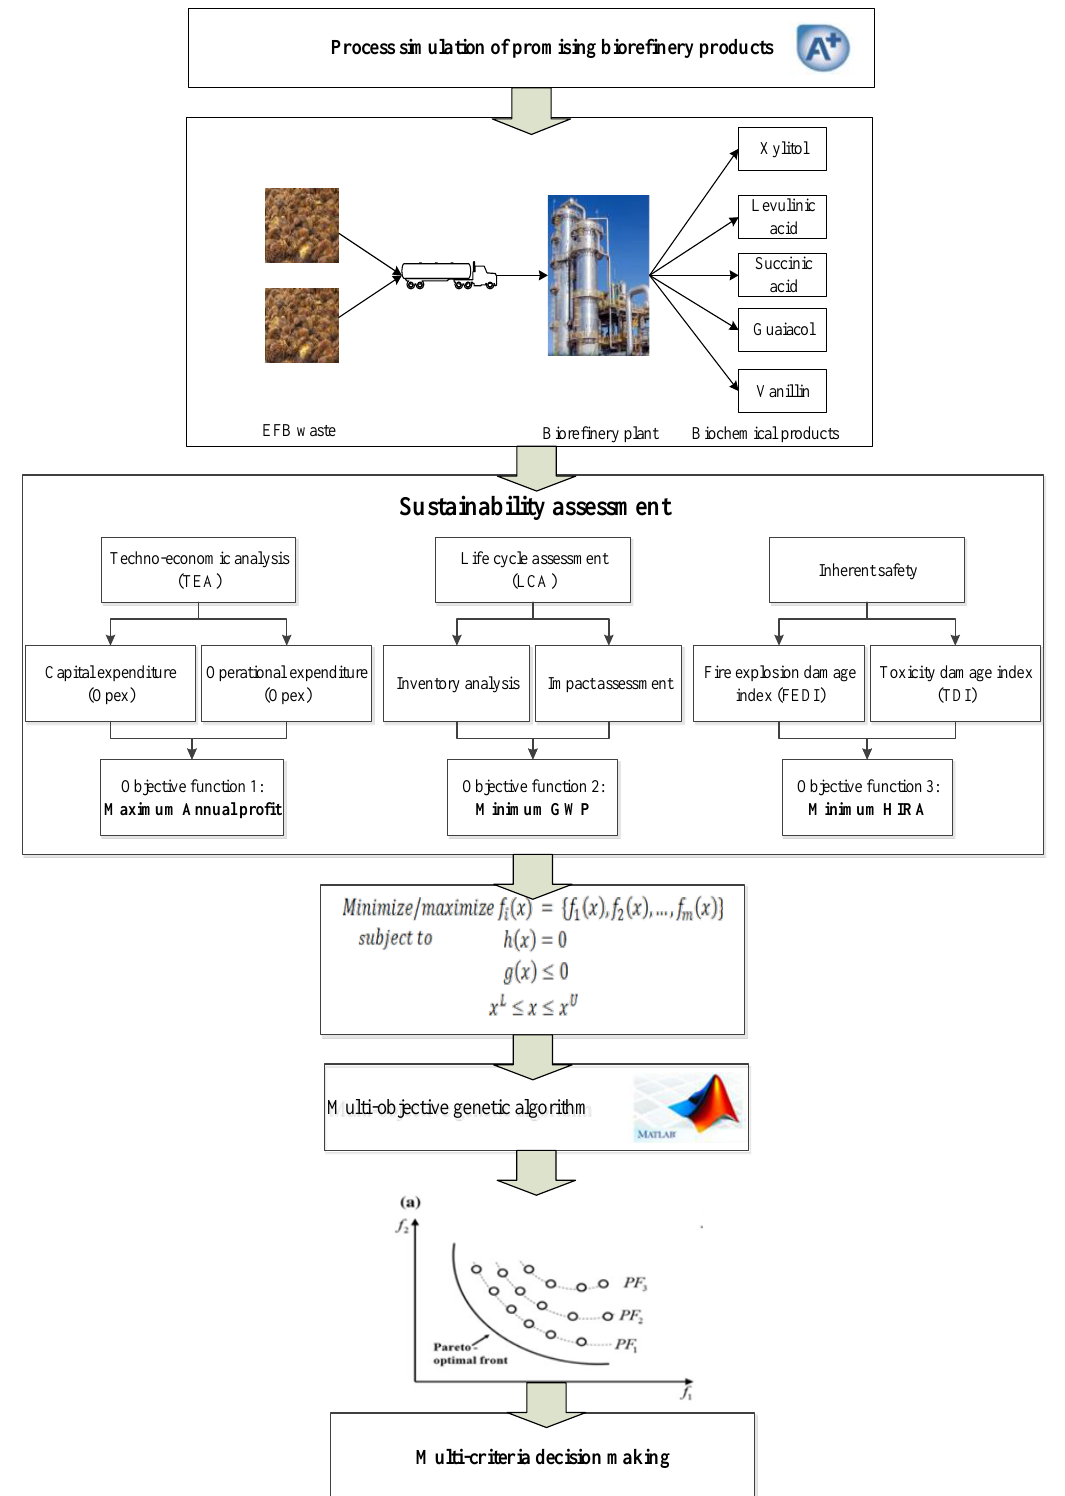
Figure 2. Methodology for identification of optimal empty fruit bunch-based biorefinery 186 Figure2. configuration. 187